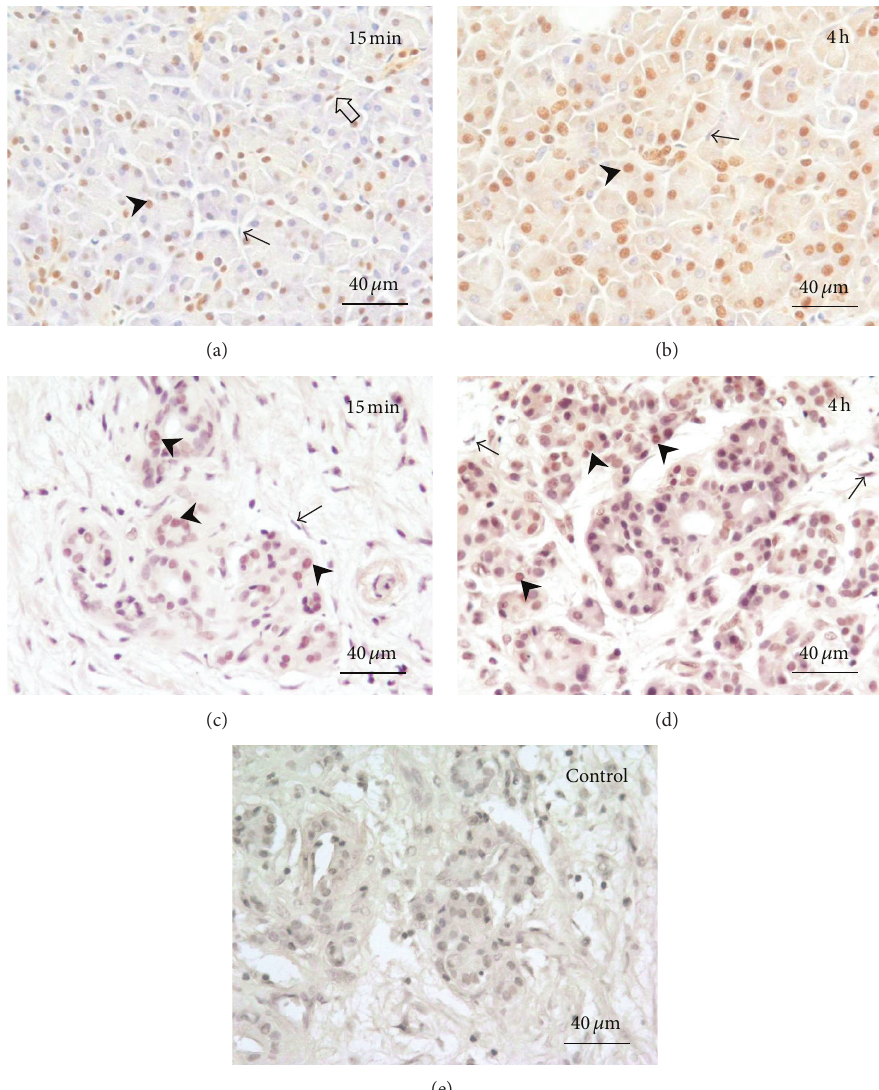
Figure 2: NF- 𝜅 B expression in acinar-cell-rich ((a), (b)) and fibrotic ((c), (d)) pancreata. (a) and (c) are 15-minute sample and (b) and (d) represent 4-hour time points. Arrowheads indicate representative NF- 𝜅 B-expressing nuclei in acinar cells. NF- 𝜅 B-positive fibroblasts were rare (open arrow in (a)), the fibroblast nuclei being predominantly negative (arrows). The increase in NF- 𝜅 B activation is more prominent in acinar-cell-rich pancreata ((a) and (b)) than in fibrotic pancreata ((c) and (d)). Control stainings were negative (e).